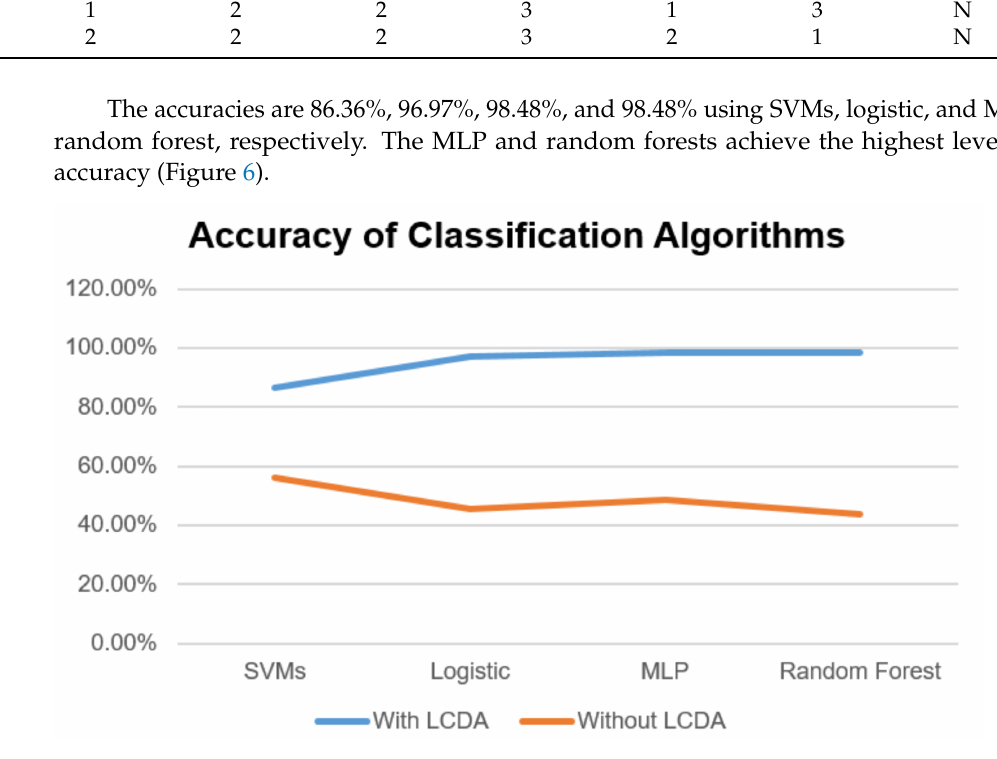
Figure 6. Accuracy of Classification Algorithms. The collaboration is built randomly 66 times, and the highest accuracy is 56.06% from SVMs. The mean difference is − 30.3 ( p < 0.01), which is significant. Therefore, the second hypothesis is also